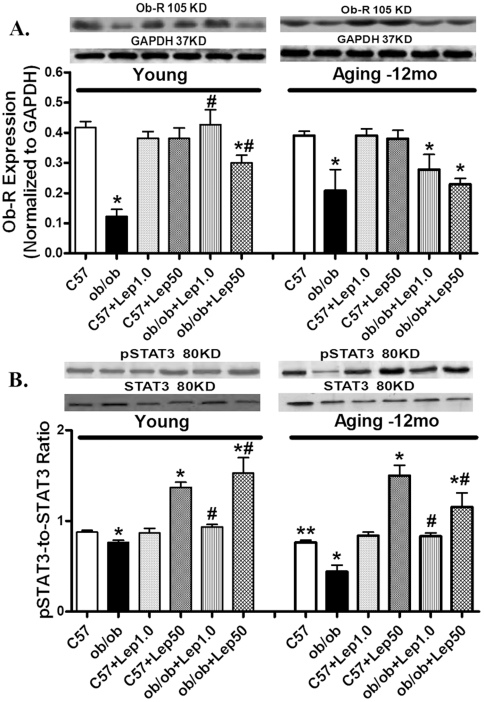
The leptin receptor Ob-R expression (Panel A) and phosphorylation of
the leptin receptor downstream signaling molecule STAT-3 (pSTAT3, Panel
B) in cardiomyocytes freshly isolated from young (4-month-old) or aging
(12-month-old) lean (C57) and ob/ob mice treated with
or without leptin (1.0 and 50 nM) for 4 hrs.Protein expression of Ob-R and pSTAT-3 was normalized to the loading
control GAPDH or total STAT-3, respectively. Insets: Representative gel
blots of Ob-R, pSTAT-3 and STAT-3 proteins using specific antibodies.
Mean ± SEM, n = 3
– 6 isolations, * p<0.05 vs.
respective C57 group, # p<0.05 vs. respective
ob/ob group.